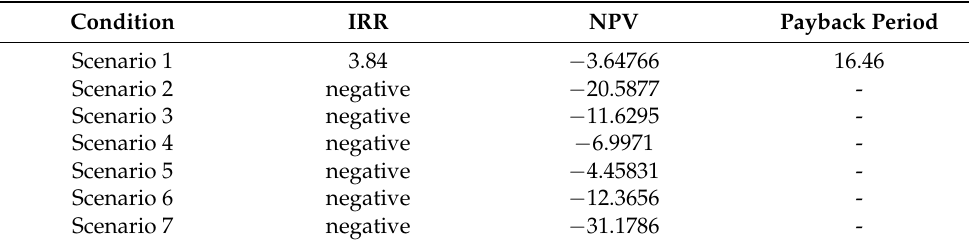
Table 15. Economic parameters of each